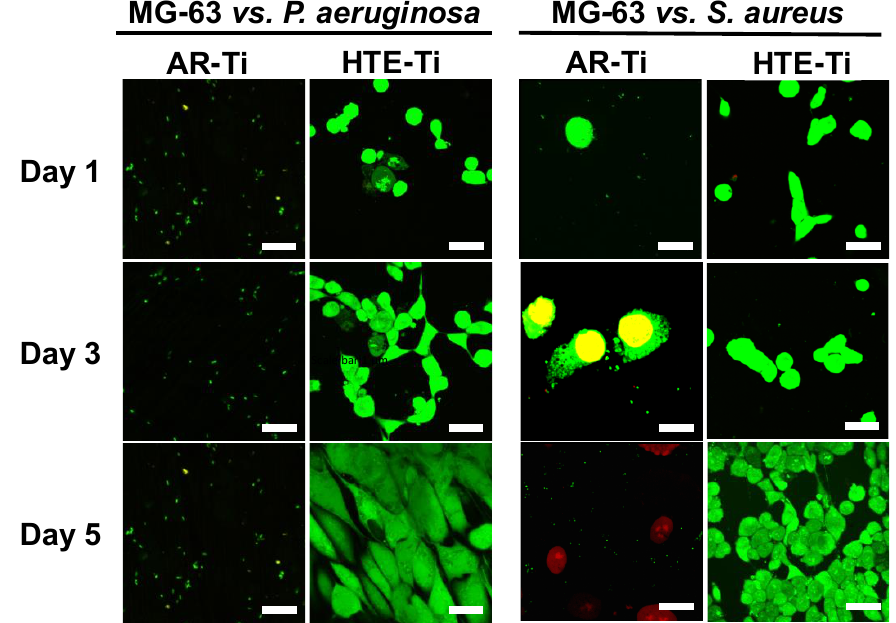
Figure 3. Typical CLSM images of MG-63 cells over a 5-day incubation period on pre-infected nanostructured HTE-Ti and smooth AR-Ti titanium surfaces. Cells on the HTE-Ti surfaces were observed to grow successfully over a 5-day incubation period, showing a healthy morphology and an elongation associated with tissue formation. Growth of the MG-63 cells on the flat, titanium surface (AR-Ti) was inhibited due to the presence of pathogenic bacteria, with cells adopting a round morphology and reduced viability. Scale bar = 5 µm.